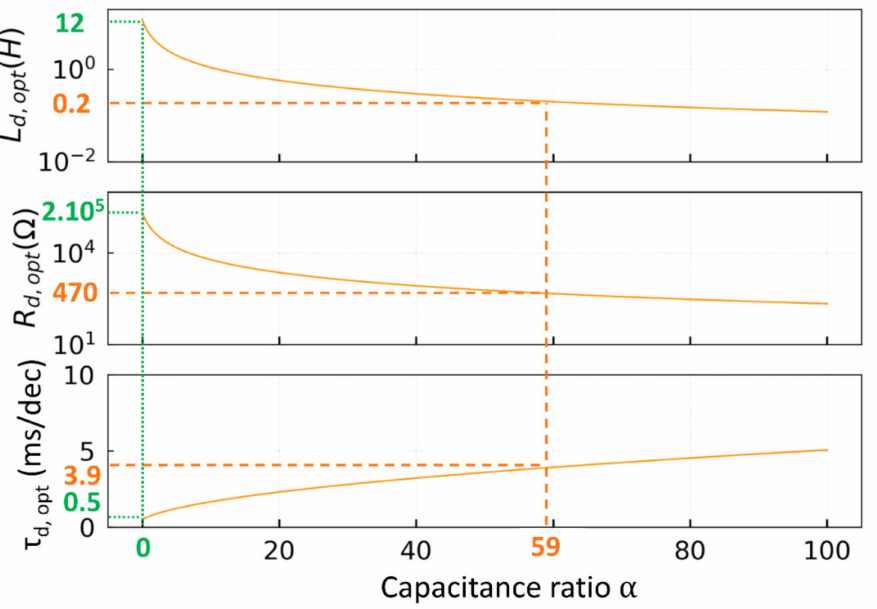
Figure 2. Evolution of the optimum damping inductance, resistance and 1-decade decay time as a function of α . The minimum decay time of 0.5 ms/dec is obtained for a capacitance ratio of 0 (green dotted line). In our case, for a damping inductance of 0.2 H, the capacitance ratio is 59, which leads to an optimal damping resistance of 470 and a decay time of 3.9 ms/dec as shown by the orange dotted